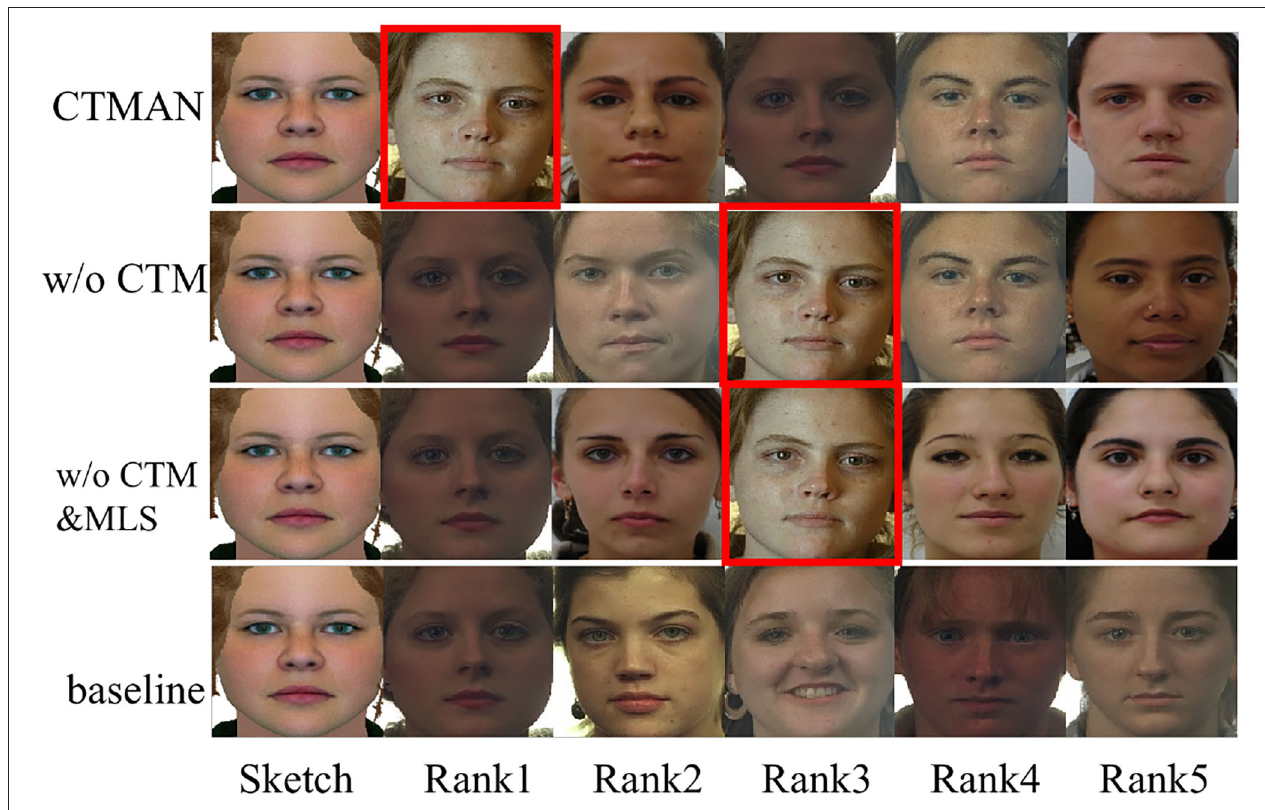
FIGURE 6 | The top five matching photos of CTMAN, w/o CTM, w/o CTM&MLS, and baseline on the S2 setup, images in red box are the